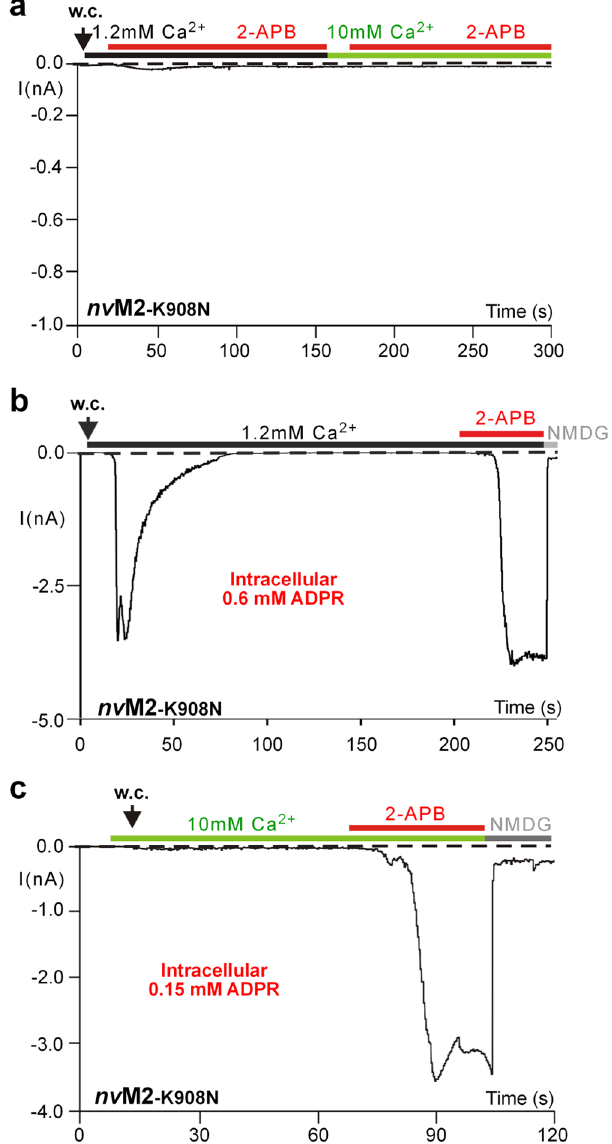
Figure 7. Diminished effects of 2-APB on nv TRPM2-K908N. ( a ) 2-APB fails to evoke currents even at elevated extracellular Ca 2 + . ( b ) 2-APB becomes effective after pre-stimulation with ADPR. In contrast to the experiment shown in panel a, ADPR was present in the pipette solution, at a roughly half-maximal concentration (0.6 mM). After complete inactivation of the ADPR-induced current, 2-APB (1 mM) was applied and did evoke sizeable currents. ( c ) 2-APB becomes effective in elevated extracellular Ca 2 + after pre-stimulation with ADPR at a sub- threshold concentration. Current recording was performed in a bath solution with 10 mM Ca 2 + and a pipette solution with 0.15 mM ADPR, which did not induce currents in this combination. Currents were only evoked by subsequent application of 2-APB (1 mM) with the typical properties. All experiments were repeated at least three times confirming the